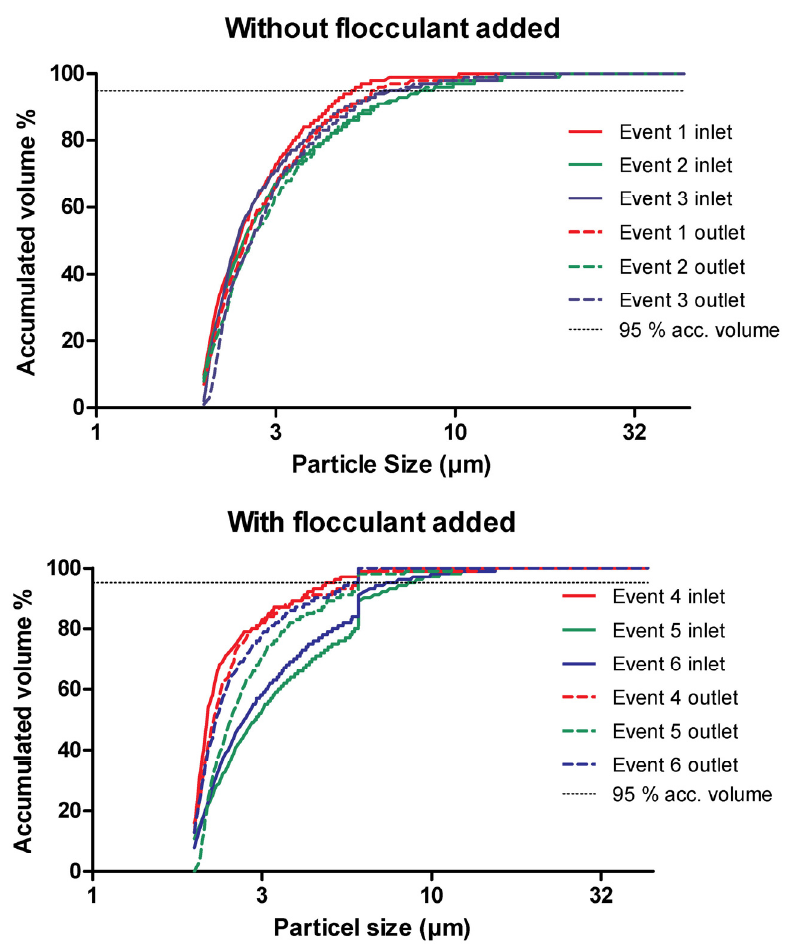
Figure 4. Micro-particle diameter size distribution (2–43 µm) measured on Coulter Counter. Inlet = untreated runoff stormwater before entering the disc filter, outlet = treated water after passing through the 10 µm disc filter. The thin horizontal line indicates the 95% accumulated volume. Note the logarithmic scale on the horizontal